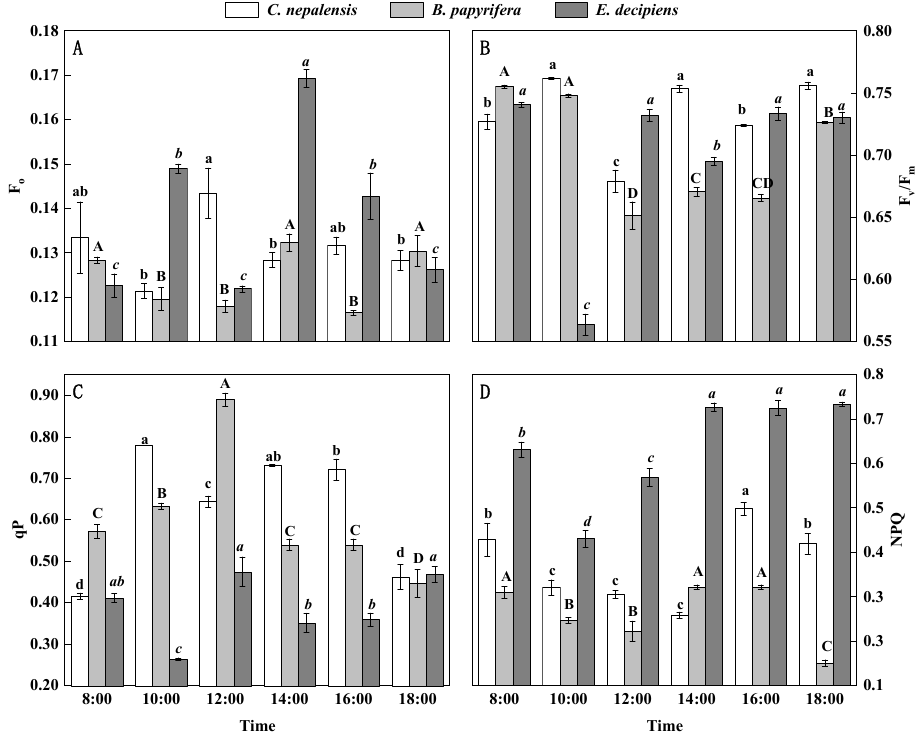
Figure 3. ( A ) Minimal fluorescence (F o ); ( B ) primary light energy conversion efficiency (F v /F m ); ( C ) photochemical quenching(qP); ( D ) non-photochemical quenching (NPQ). Different lowercase letters appear above error bars of the same plant species when subsequent values significantly differ at p ≤ 0.05 according to one-way ANOVA. A, b, c, etc., indicate differences between values of C. nepalensis ; A, B, C, etc., indicate differences between values of B. papyrifera ; a, b, c, etc., indicate differences between values of E. decipiens